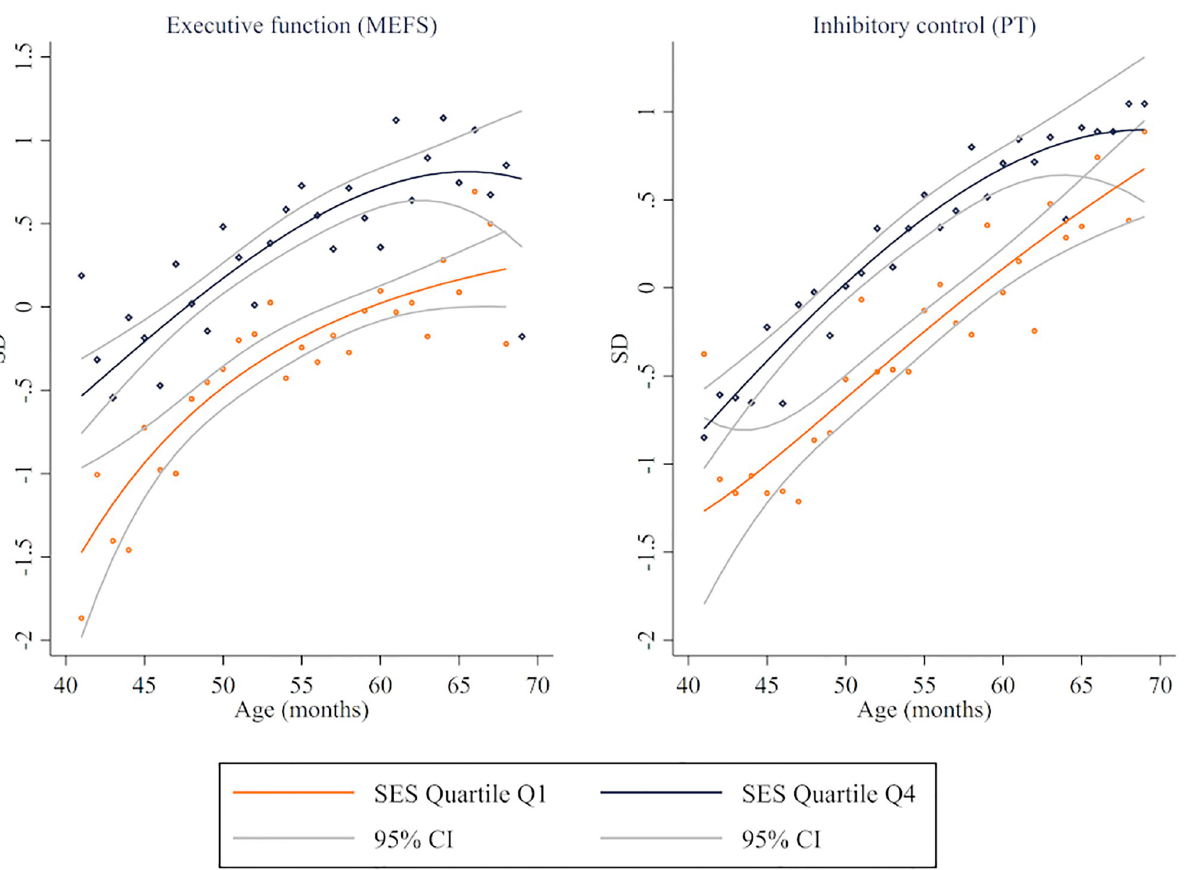
Fig 2. Executive function by SES quartile. Fractional-polynomial plots by developmental